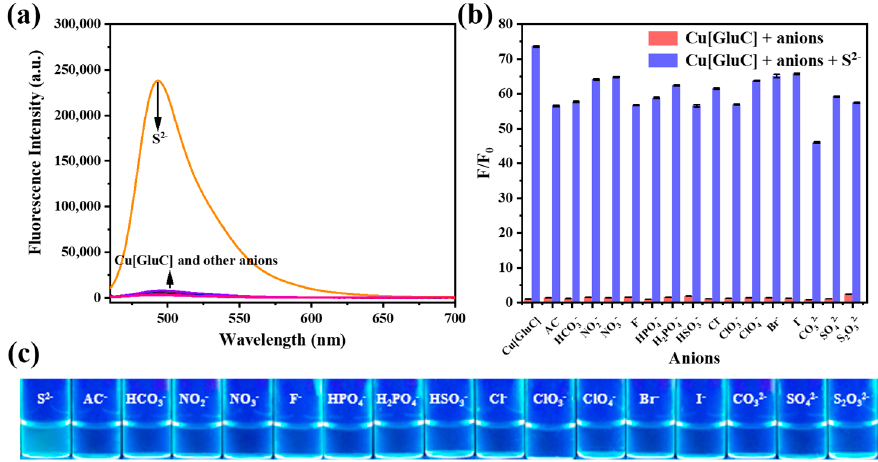
Figure 3. ( a ) Fluorescence emission spectra of Cu[GluC] aqueous solution (10.0 μ M) after adding different anions (30.0 μ M); ( b ) Fluorescence intensity of Cu[GluC] aqueous solution (10.0 μ M) at 494 nm in the presence of different anions (30.0 μ M) and then adding S 2 − (30.0 μ M) in water ( n = 3);